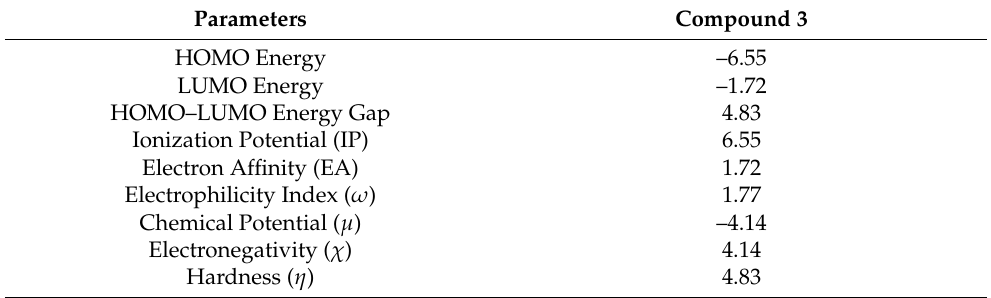
Table 7. HOMO/LUMO energies (eV) and global reactivity descriptors (eV) for compound 3 .